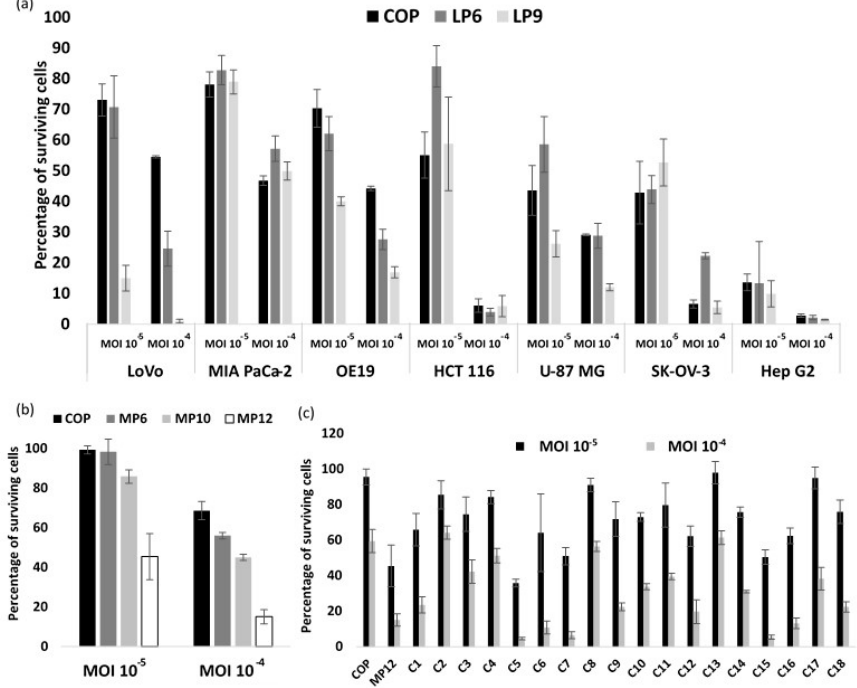
Figure 2. Oncolytic activities during the different steps of the directed evolution process. ( a ) Percentage of surviving cells 5 days after infection with passage 6 (LP6), passage 9 (LP9)